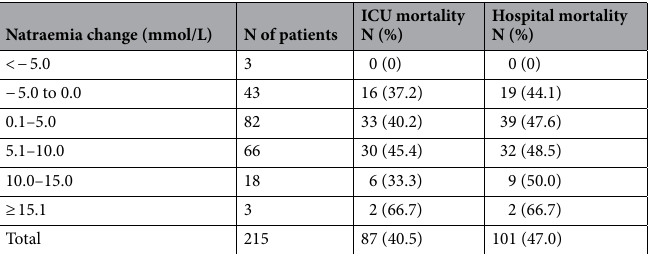
Natraemia change (mmol/L) N of patients